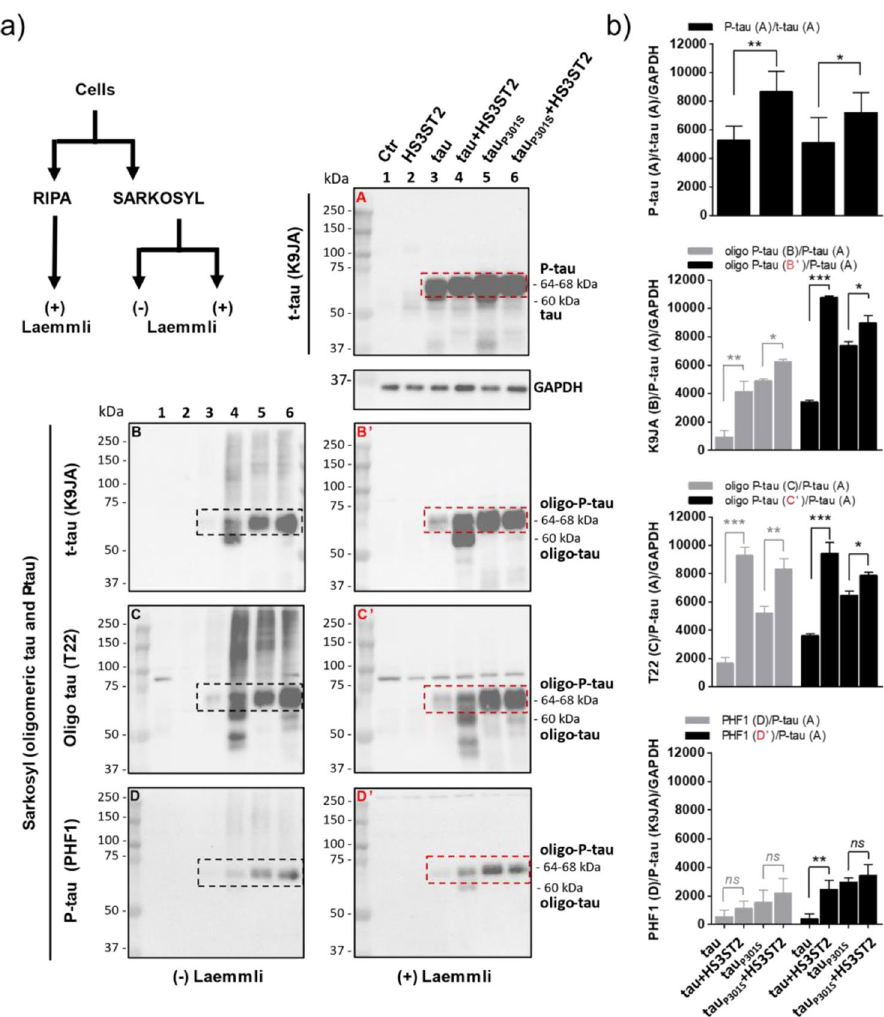
Figure 4. HS3ST2 promotes tau aggregation in tau expressing cells. ( a ) High-salt Sarkosyl and RIPA buffer protein extracts were analysed in cell lysates from control and transfected cells. Immunoblotting of RIPA (blot A) and high salt Sarkosyl buffer (blots B-D and B’-D’) extracted proteins were performed before and after protein denaturation by heating in Laemmli buffer (B-D and B’-D’, respectively). Total tau (K9JA, blot A), oligomeric total tau (blots B-C and B’-C’), and oligomeric tau hyperphosphorylated at serine 396/404 (PHF1 antibody, blots D and D’) were analysed before and after denaturation. ( b ) Total tau, oligomeric-tau (oligo-tau), and P-tau signal intensities were quantified by ImageJ. Mean values ± SD are represented. Immunoblot analyses were calculated by one-way ANOVA with Tukey’s test, as indicated (*** P < 0.001; ** P < 0.01; * P < 0.05; ns = not significant). Experiments were reproduced twice with similar